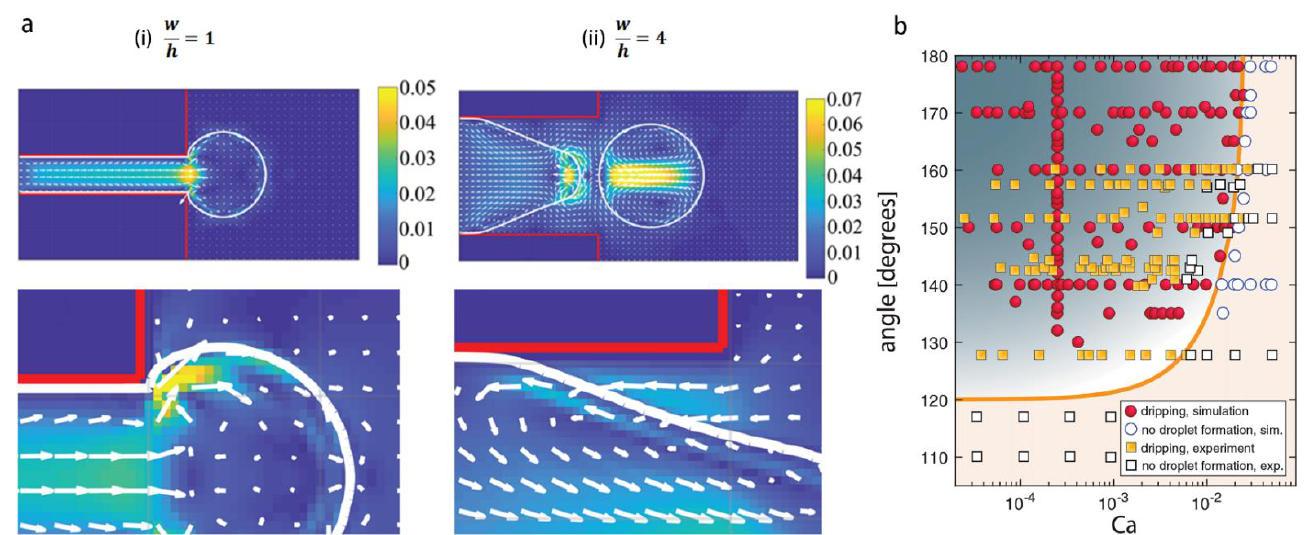
Figure 7. Operational conditions for step-emulsification of highly monodisperse droplets. ( a ) Flow field in channel with aspect ratio 1 ( i ) and 4 ( ii ). A back flow is allowed in the channel with aspect ratio 4, which promotes pinching at the step. Reproduced from [81], copyright 2019, AIP. ( b ) Phase diagram of droplet formation in plane of capillary number and contact angle of the disperse fluid on channel wall. A minimum 120 ° is required for having dripping mode, which generates monodisperse droplets at high rate. Reproduced from [82], copyright 2018, NAS of the USA.